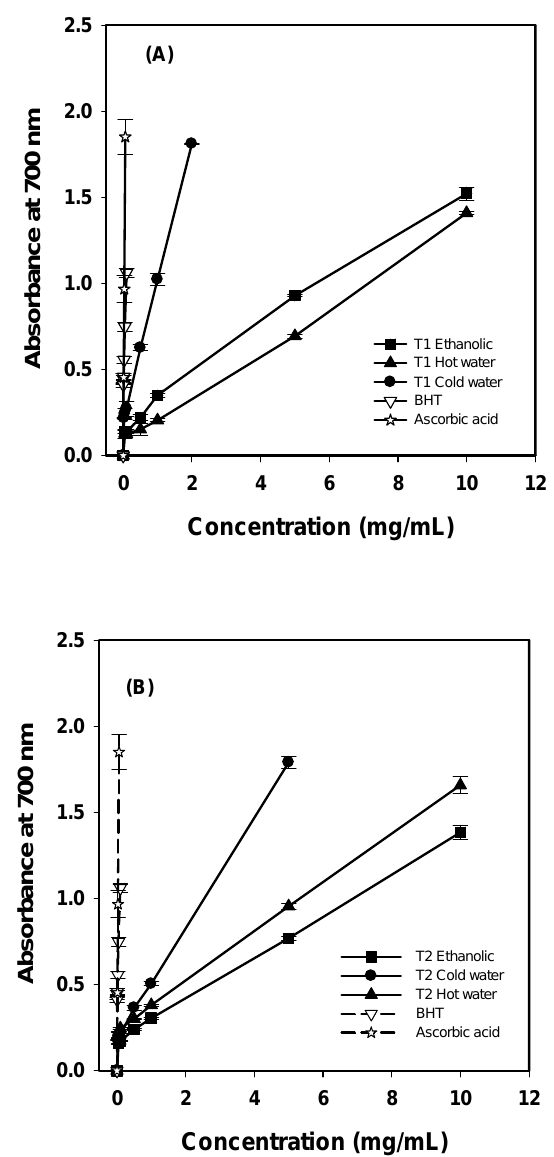
Figure 1. Reducing power of various extracts from G. frondosa T1 (A), and G. frondosa T2 (B). Each value is expressed as mean ± S.D. (n =